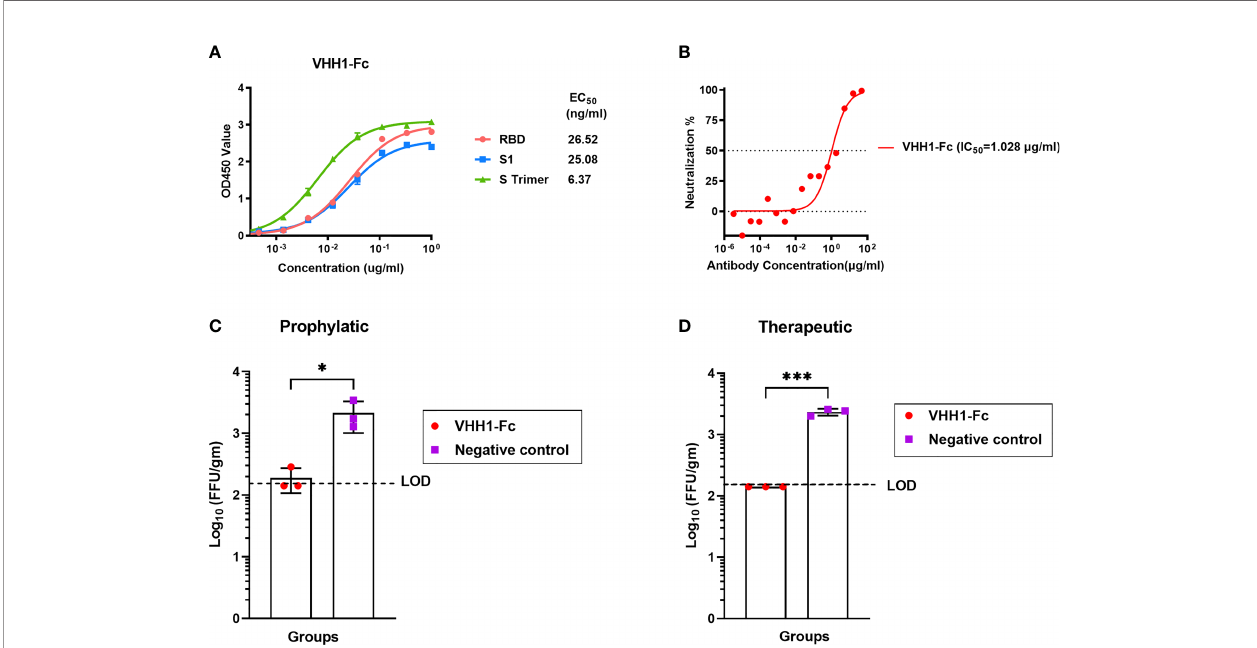
FIGURE 7 | MERS-CoV-speci fi c alpaca VHHs protected mice from MERS-CoV infection. (A) Binding activity of VHH1-Fc with MERS-CoV RBD, S1, and S trimer protein were measured by indirect ELISA. (B) Neutralizing activity against MERS-CoV prototype strain EMC/2012 was evaluated by pseudovirus neutralization assay. (C) Prophylactic and (D) therapeutic administration of VHH1-Fc protected MERS-CoV-infected mice (n = 3 per group). The prophylactic and therapeutic ef fi cacies of VHH1-Fc were evaluated in vivo using Ad5-hDPP4-transduced mice challenged with MERS-CoV. VHH1-Fc was intravenously transferred 1 day before or after MERS-CoV (EMC/2012 strain) infection. The lungs were harvested at 3 days post-infection for viral titer determination. Mice in the control group (n = 3) were negative control antibodies (anti-HIV antibody 2G12) at the same time points. Data are shown as mean ± SD. Data were obtained using GraphPad Prism version 9.0 (GraphPad software). An unpaired Student ’ s t-test (two-tailed) was used for statistical analysis, and the relevant p-values are indicated (not indicated in graph; *p < 0.05, ***p <